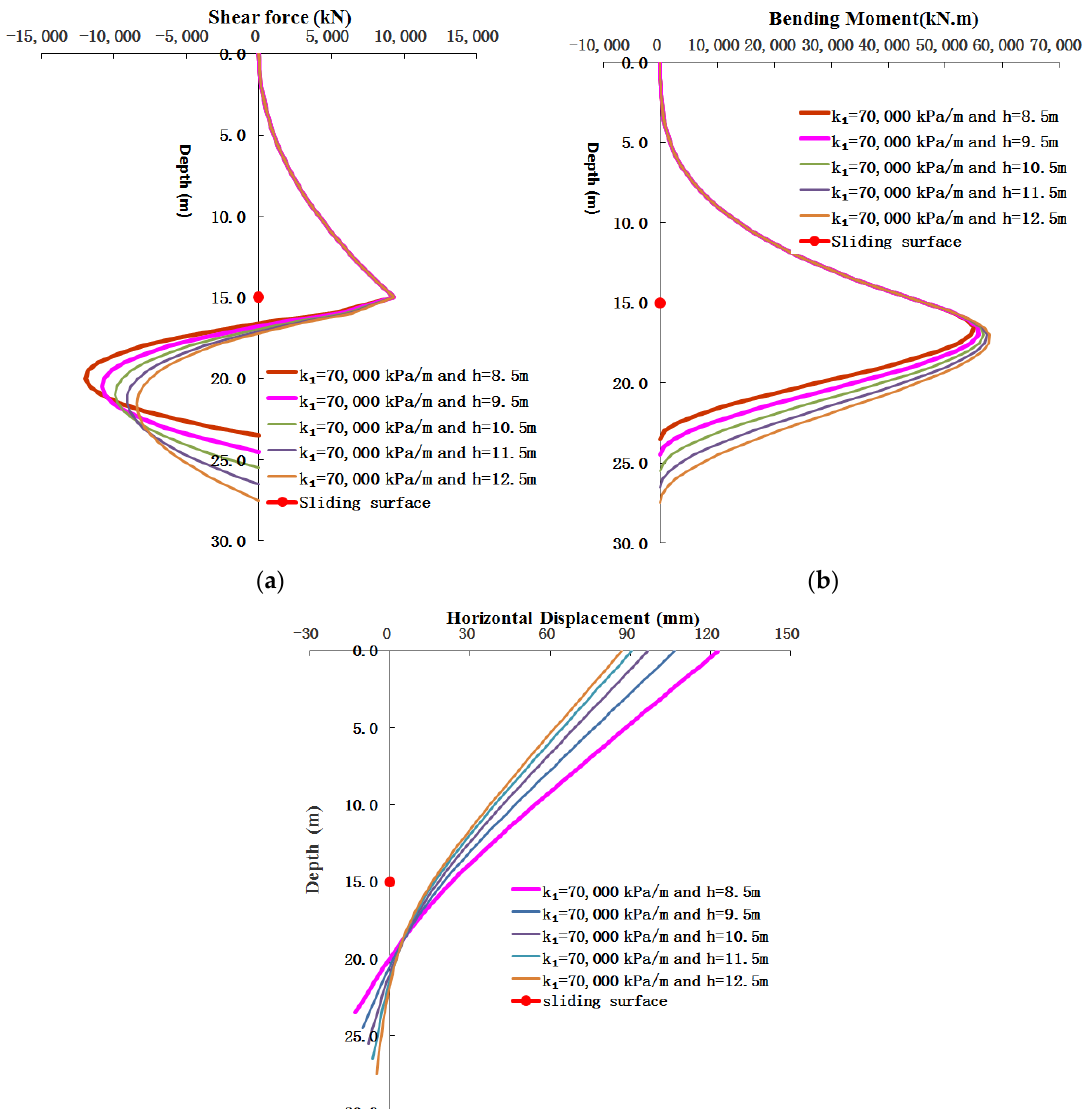
Figure 8. Calculated values of internal forces for piles of various embedded lengths with k 1 = 70,000 kPa/m: ( a ) shear force; ( b ) bending moment; ( c ) horizontal displacement.